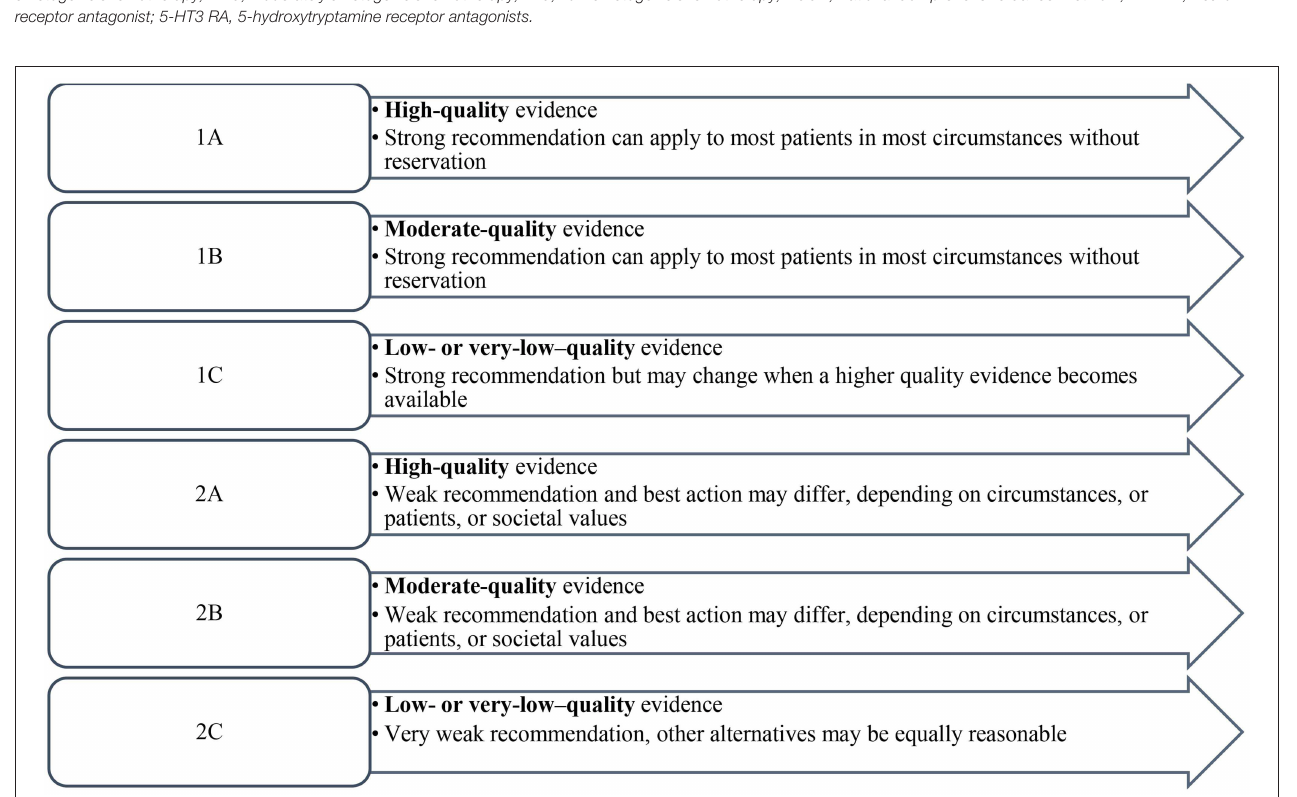
adherence to protocol therapy. Nonadherence to protocol therapy, in turn, affected the survival of the patient [16]. Furthermore, uncontrolled CINV leads to increased resource utilization, thereby increasing the total healthcare cost